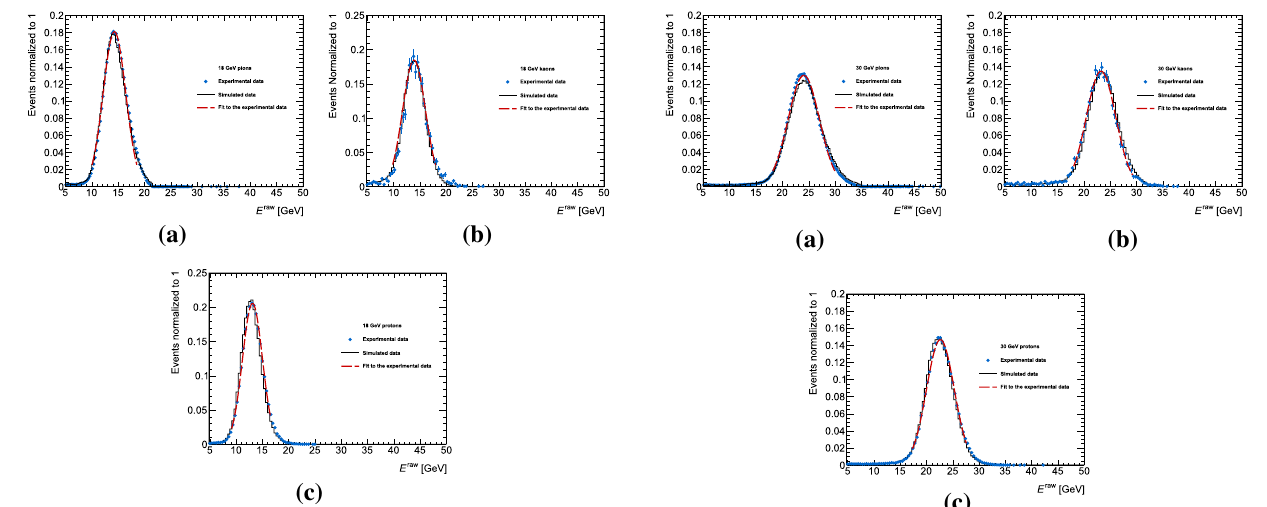
Fig. 17 Distributions of the reconstructed energy E raw obtained ana- lyzing pion ( a ), kaon ( b ) and proton ( c ) data with E beam = 18 GeV. The blue dotted histograms represent the experimental data. Only statistical uncertainties are shown. The dashed curves in red correspond to the fit of a Gaussian function to the experimental data in a region ± 2 σ around the peak value. The black histograms correspond to the predictions of the MC simulation